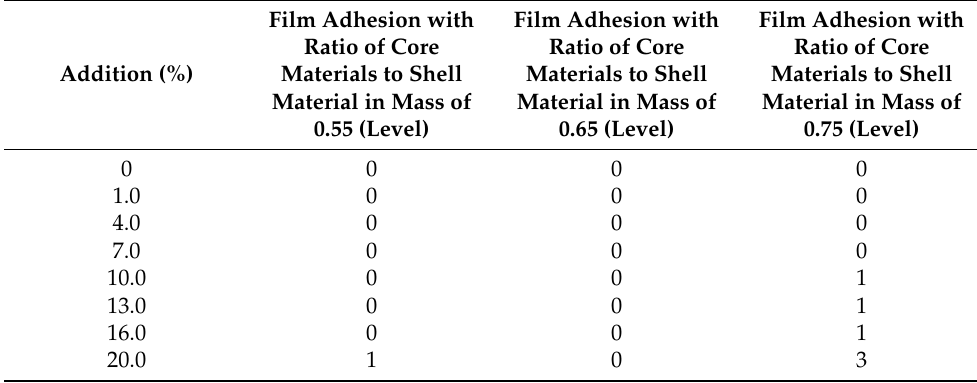
Table 4. Effect of microcapsule content on film